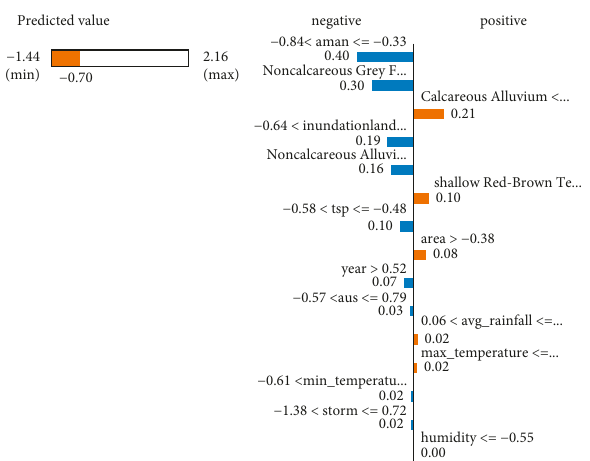
Figure 27: A plot of LIME model values for the XGBoost model and Boro yield